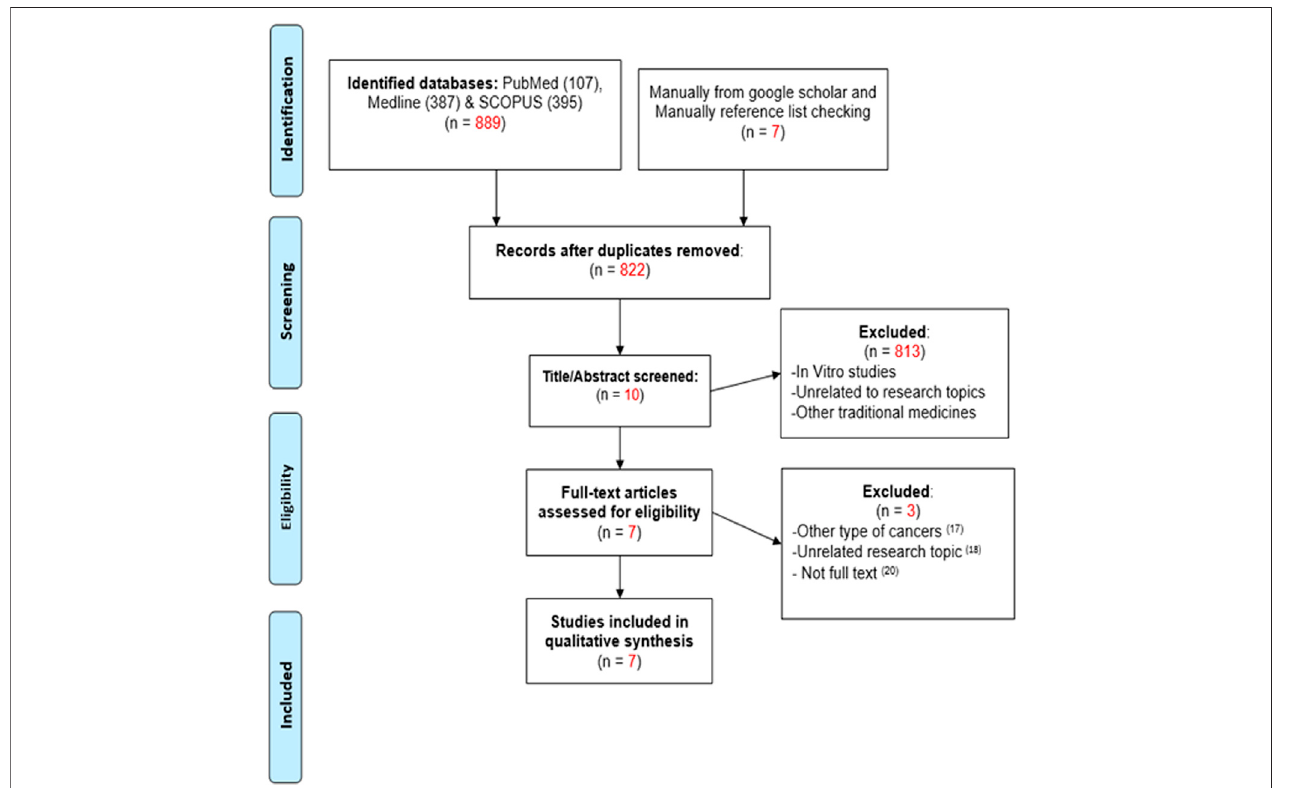
FIGURE 1 | The PRISMA fl ow diagram for article